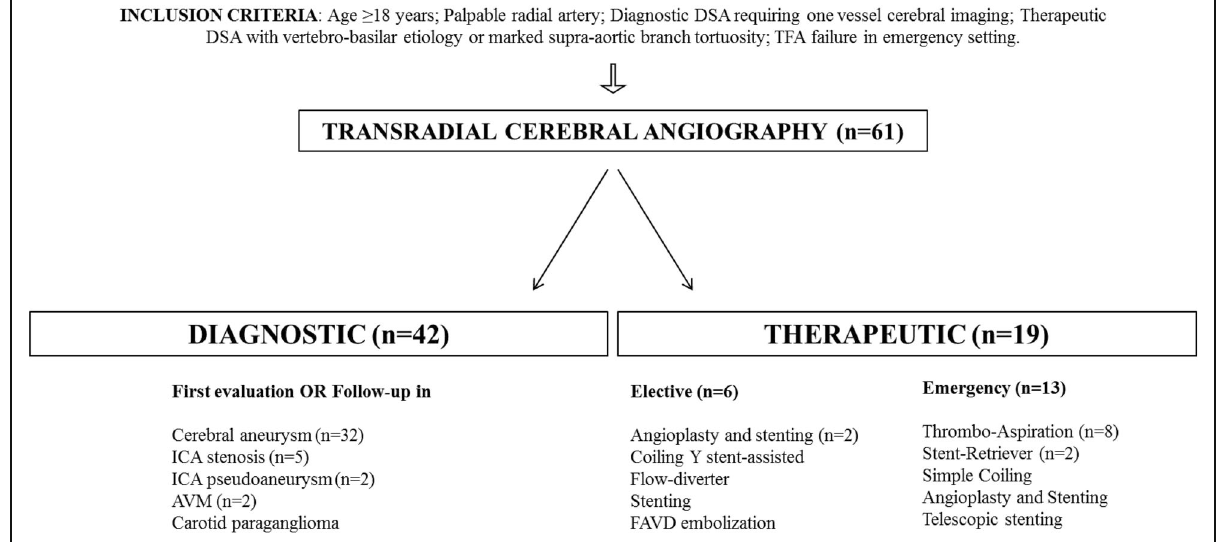
Fig. 1 Schematic representation for inclusion criteria and cerebral angiography classification in patients undergoing trans-radial access